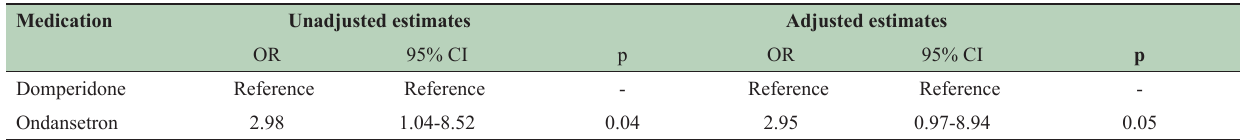
Table-II: Unadjusted and Adjusted odds ratio comparing the effectiveness of ondansetron against domperidone (reference) for controlling vomiting in participants